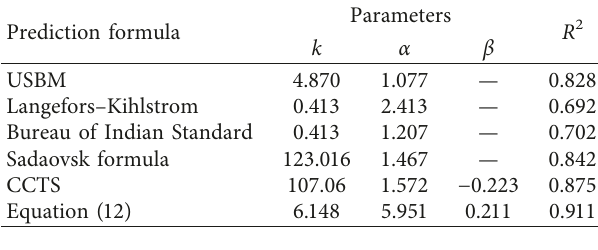
Table 8: Fitting results of different prediction formulas.